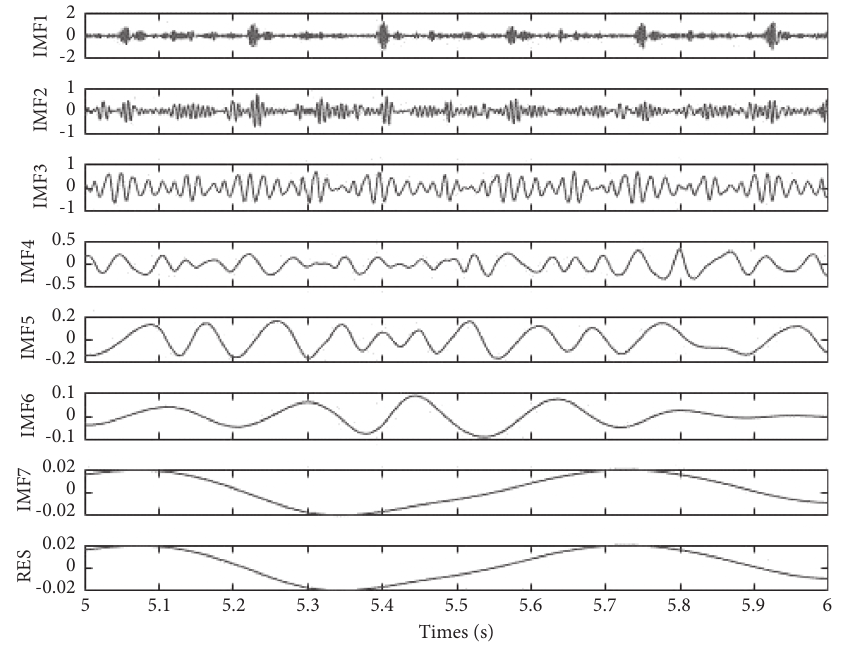
Figure 6: Results of CEEMDAN